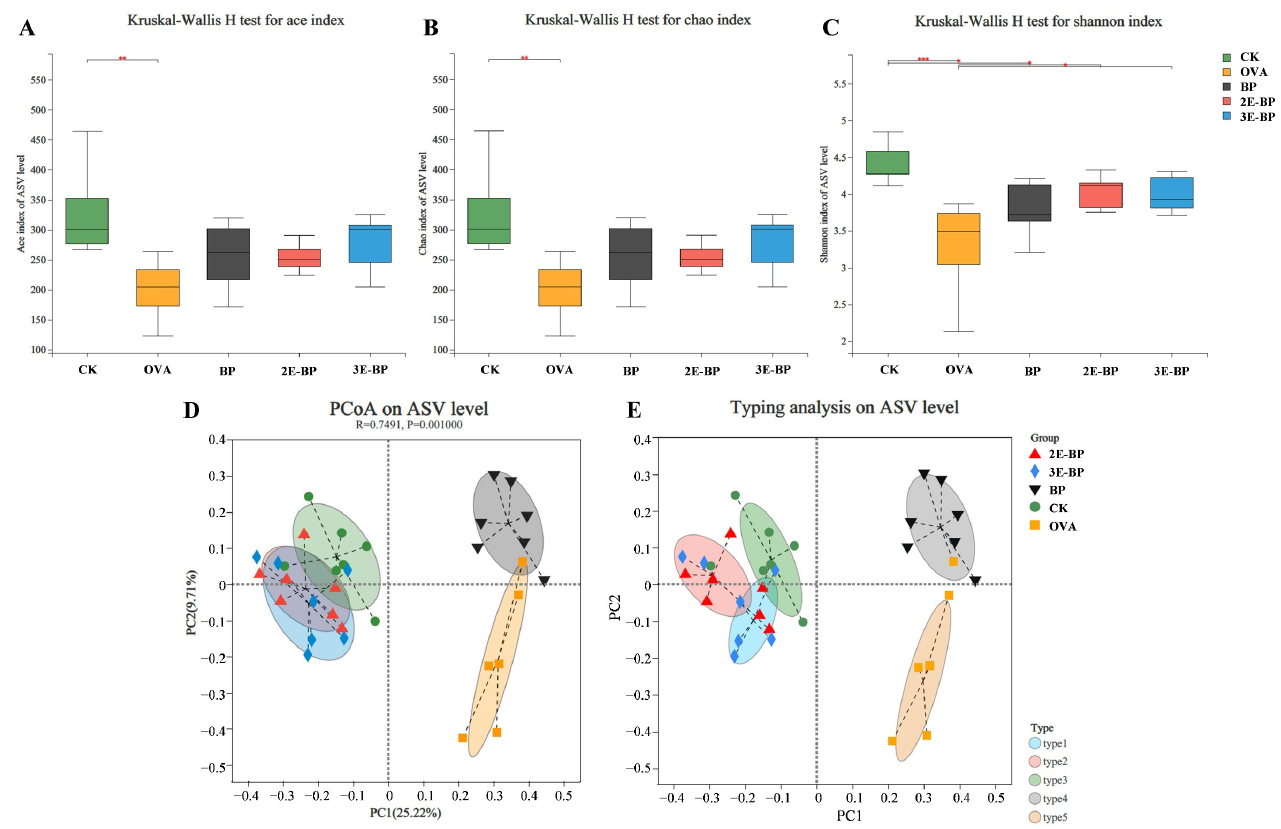
Figure 5. The alpha-diversity and beta-diversity analysis of different samples at ASV level, including ( A ) Ace index analysis; ( B ) Chao index analysis; ( C ) Shannon index analysis; ( D ) PCoA analysis; ( E ) Typing analysis. Asterisk * represents p < 0.05, ** represents p < 0.01, and *** depicts p <